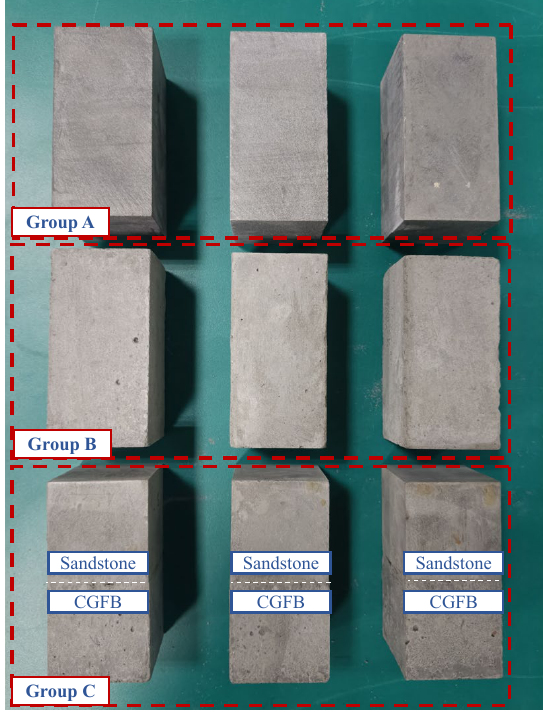
Figure 2. Sandstone, CGFB, and sandstone–CGFB composite samples.